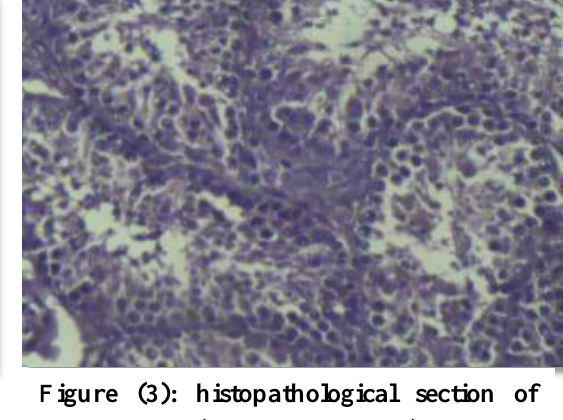
Figure (2): Histopathological section of ram testis (June) showing normal structure appearance of testicular tubules with presence of little sperms (arrows) inside the lumen of tubule. HE stain X200